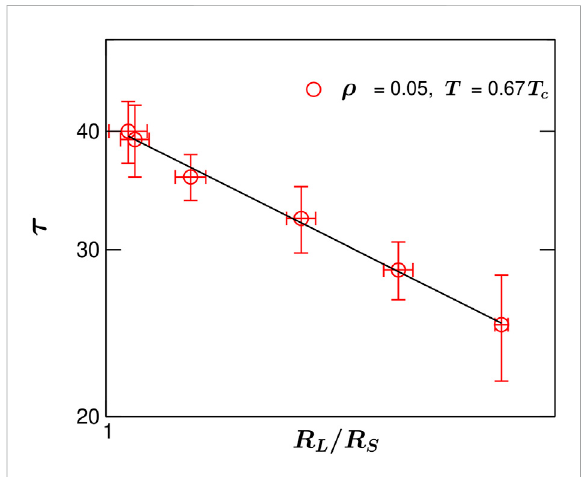
Coalescence time τ vs. the parent droplet size ratio R L / R S on the double-logarithmic scale, during droplet coalescence in a phase-segregating single-component fl uid. Data correspond to the overall system density ρ =0.05 and the quench temperature T =0.67 T c andcoalescenceeventsarecollectedfrom various system sizes L *. The solid line refers to a power-law decay with an exponent n =1.1.